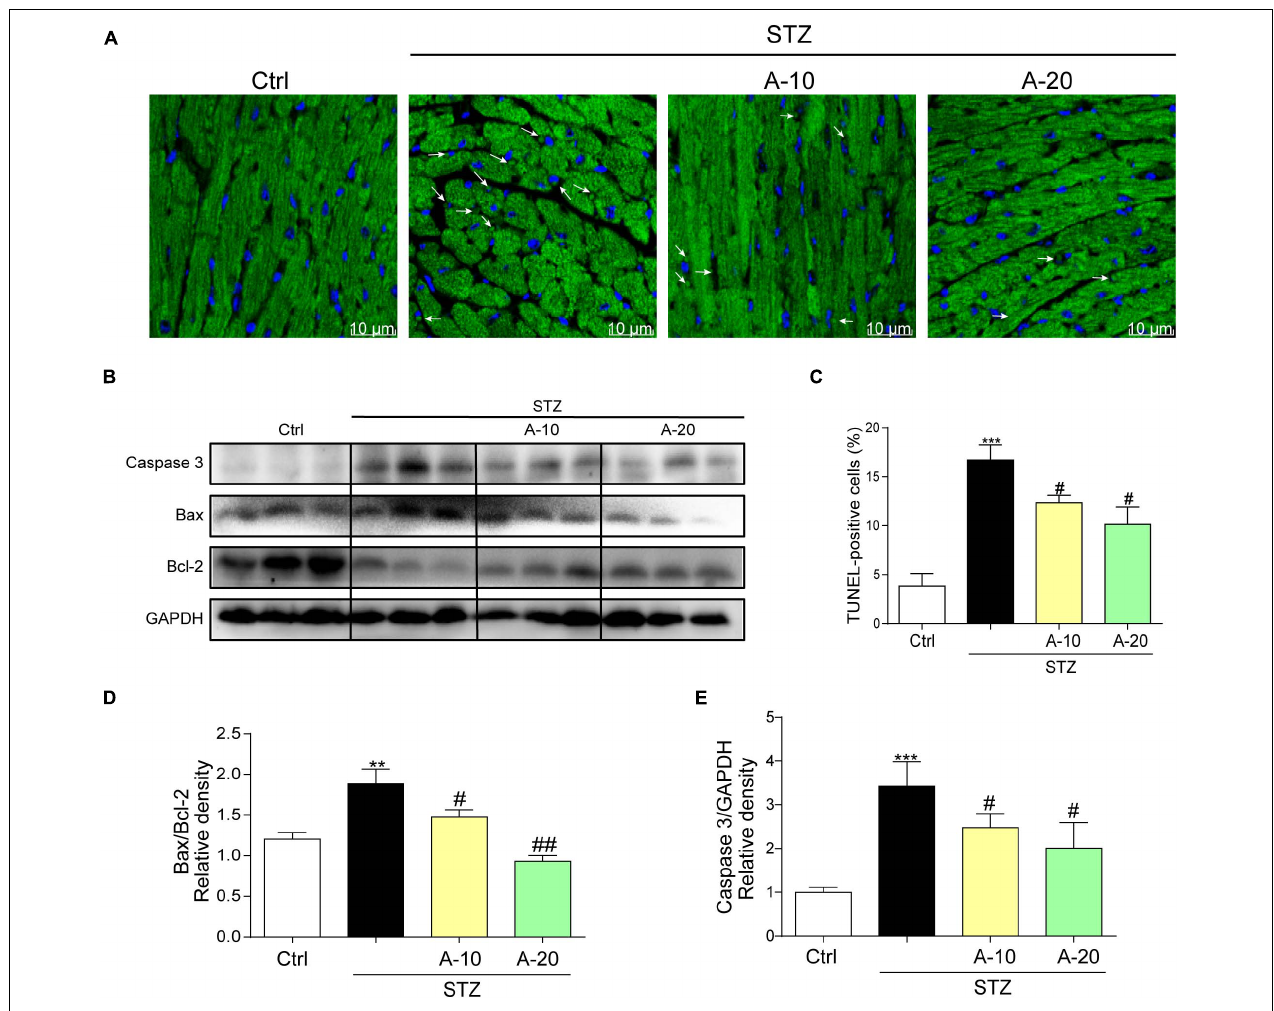
FIGURE 3 | Blockade of the P2X7 receptor improved STZ-induced cardiac apoptosis. Representative images (A) and quantification (C) of TUNEL staining in mouse myocardial tissues are shown (400 × magnification). Levels of the apoptosis-related proteins Caspase-3, Bcl-2, and Bax were measured by western blot (B) . ( n = 3 per group). The ratio of the Bcl-2 protein to the Bax protein and the ratio of Caspase3/GAPDH proteins are shown (D,E) (data from three independent experiments were analyzed: * p < 0.05, ** p < 0.01, and *** p < 0.001 compared with the Ctrl; # p < 0.05, ## p < 0.01, and ### p < 0.001 compared with STZ alone).